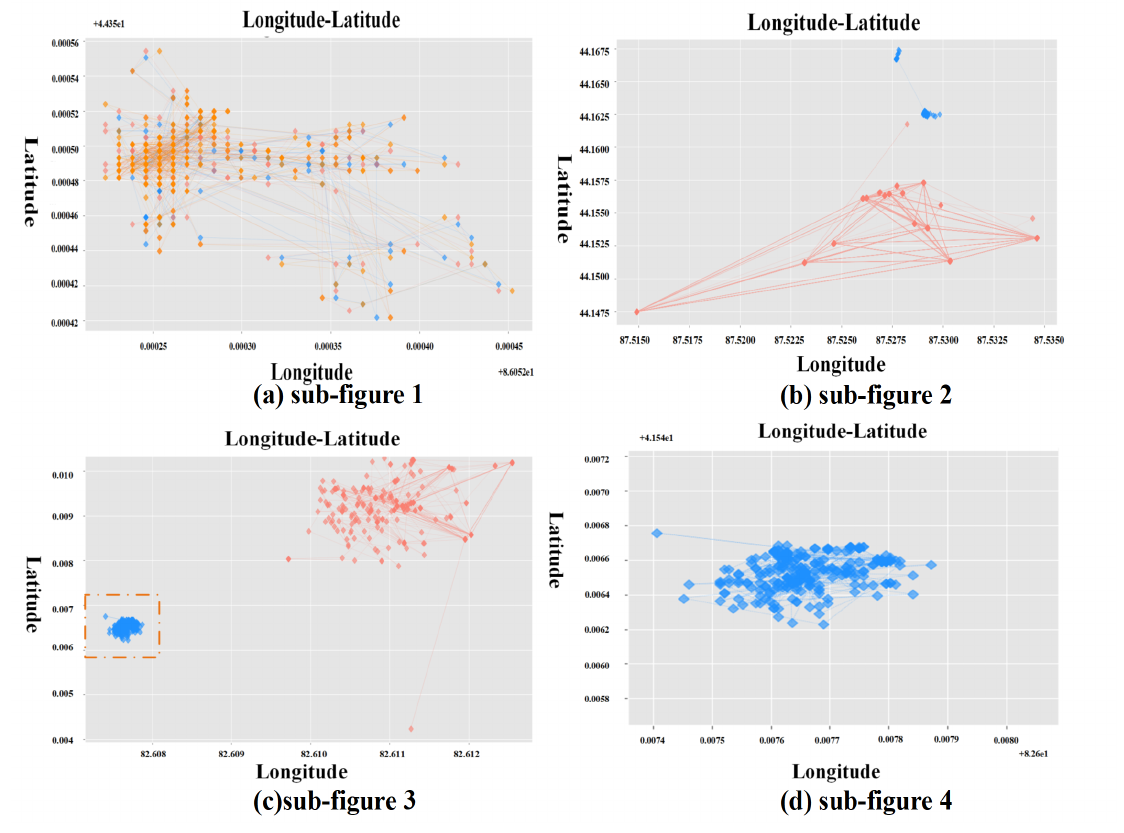
Figure 7. ( a – d ) Filtered